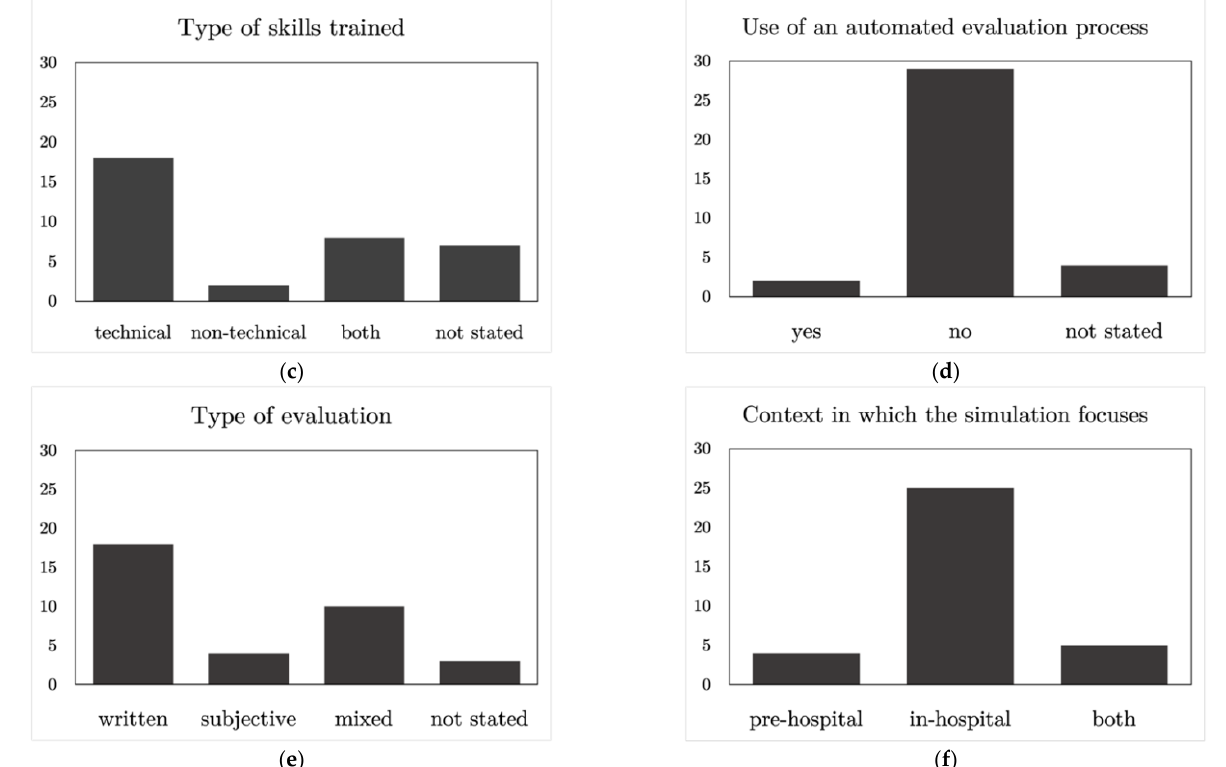
Figure 2. Results of the different aspects highlighted in this scoping review: ( a ) the focus on medical students of the trainings, ( b ) the use of high-fidelity mannequin simulators, ( c ) the type of skills trained, ( d ) if there is an automated evaluation process, ( e ) the type of evaluation used in the training, and ( f ) the context in which the simulation focuses.